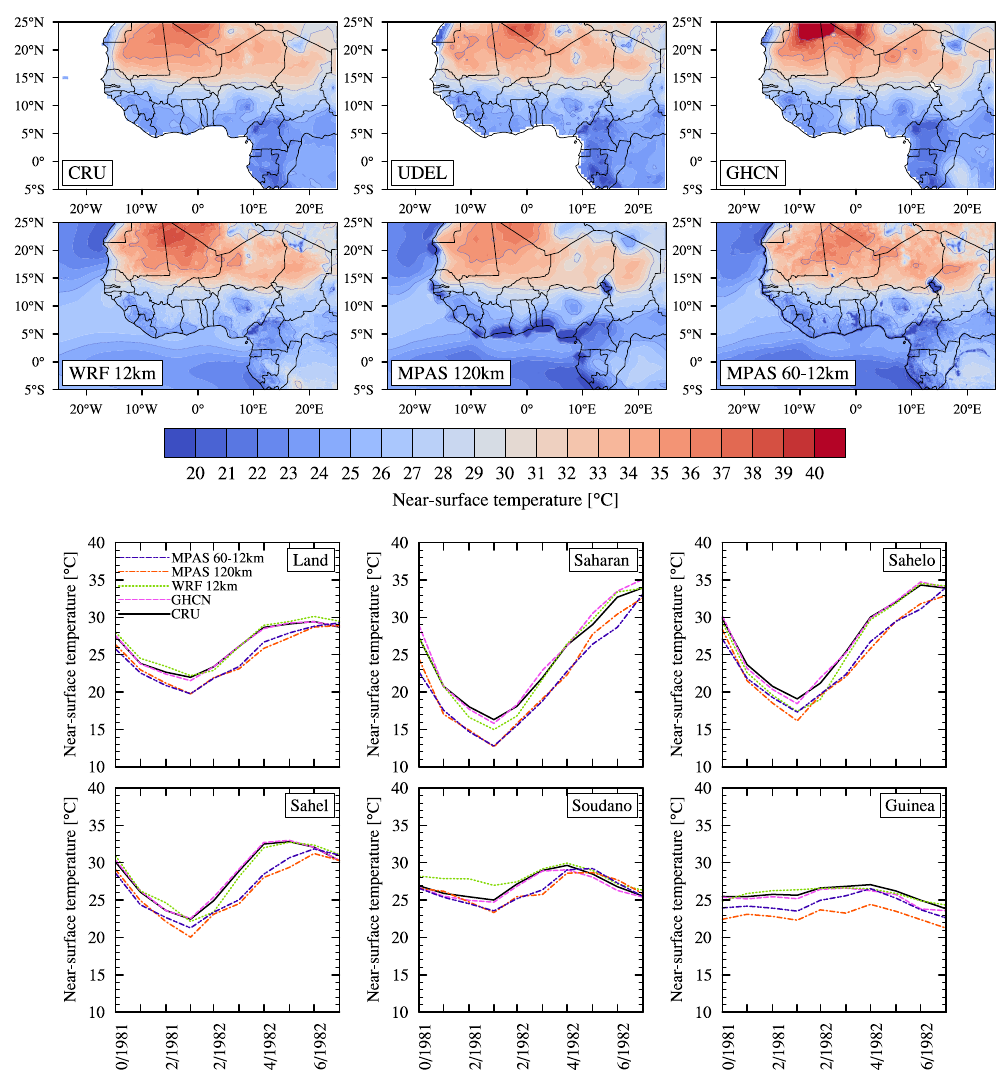
Figure 9. (Top) mean near-surface temperature (over land) in ◦ C for July 1982 for the three observational data sets CRU, UDEL, GHCN, the WRF reference and the two MPAS model runs; (bottom) annual cycle of mean near-surface temperature over the entire land area and the five agro-climatical zones depicted in Fig.